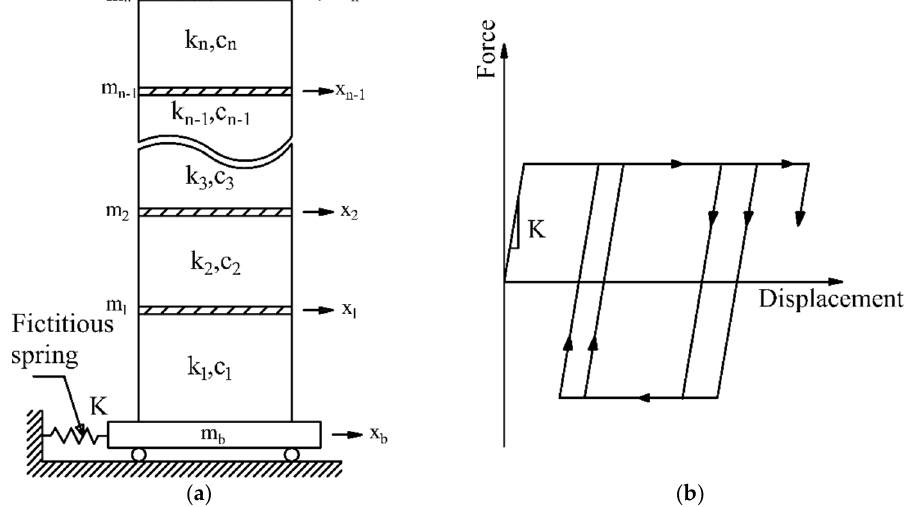
Figure 11. Structure considered by Yang et al. [32]. ( a ) MDOF system with fictitious spring, ( b ) force- displacement bbehavior of the spring.